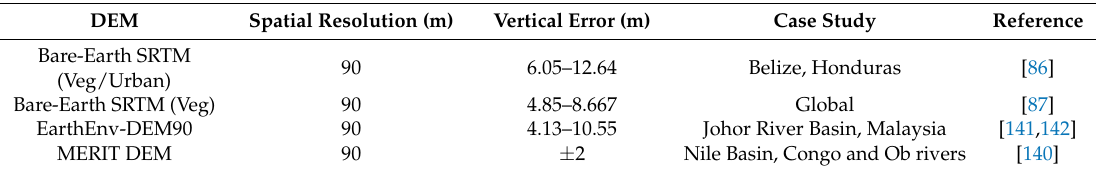
Table 4. Globally available Modified SRTM DEM properties and case